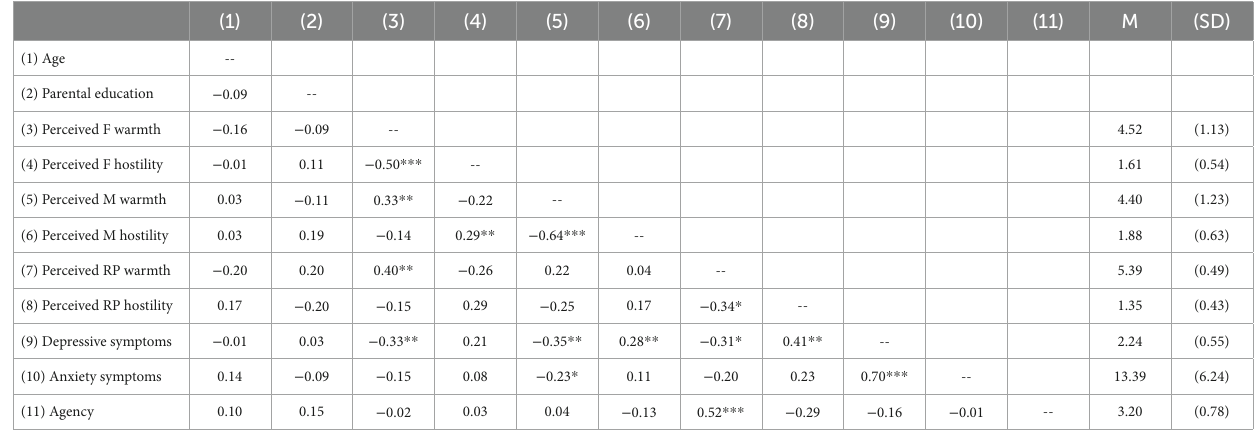
TABLE 1 Zero-order correlations and descriptive statistics for the key study